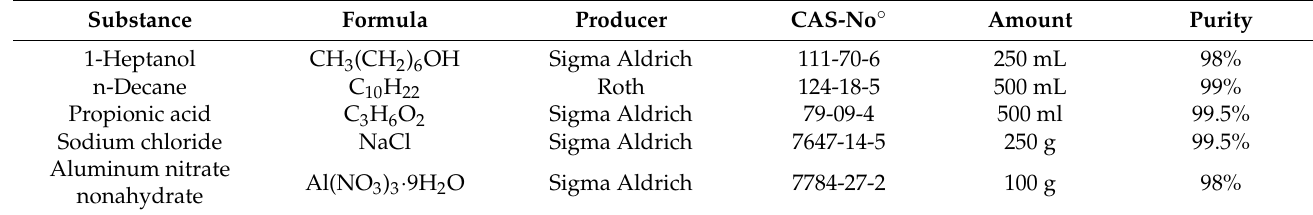
Table 1. Materials used for PCM